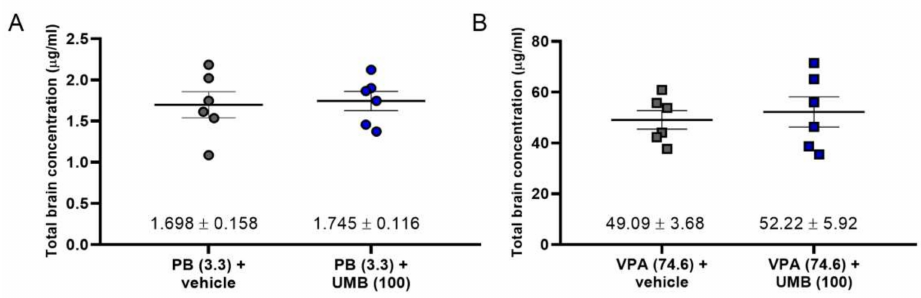
Figure 2. ( A , B ) Influence of UMB on total brain concentrations of classical ASMs in mice. Scatter plots represent total brain concentrations of PB and VPA in µ g/mL (as means ± SEM, as the error bars; n = 6 mice/group). No statistical significance between the means was observed (unpaired Student’s t -test).